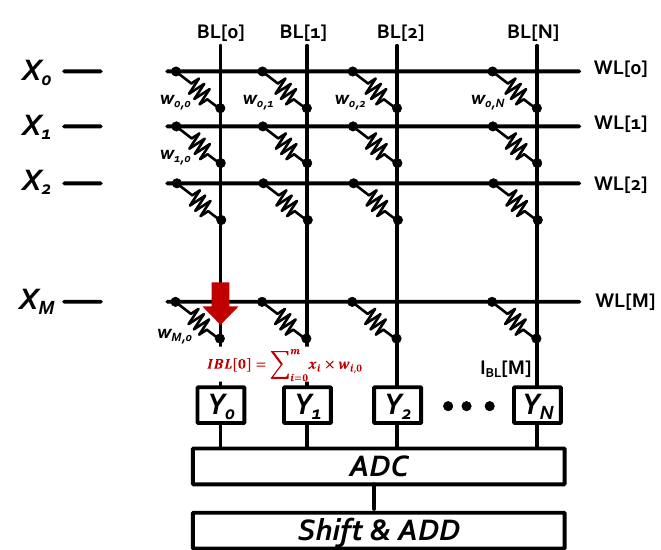
Figure 2. The concept of CIM macro.